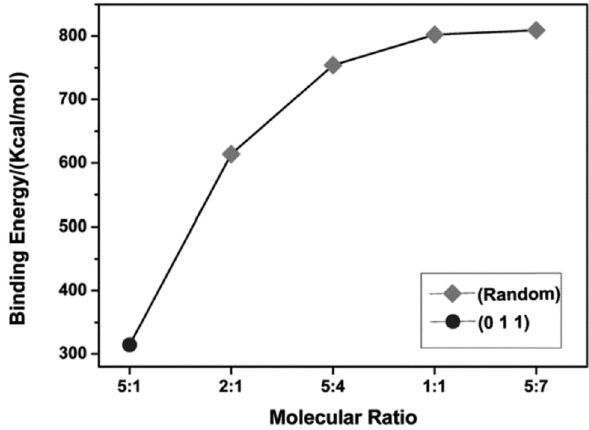
Figure 2: Change rules of binding energy at di ff erent faces and ratios [ 79 ]